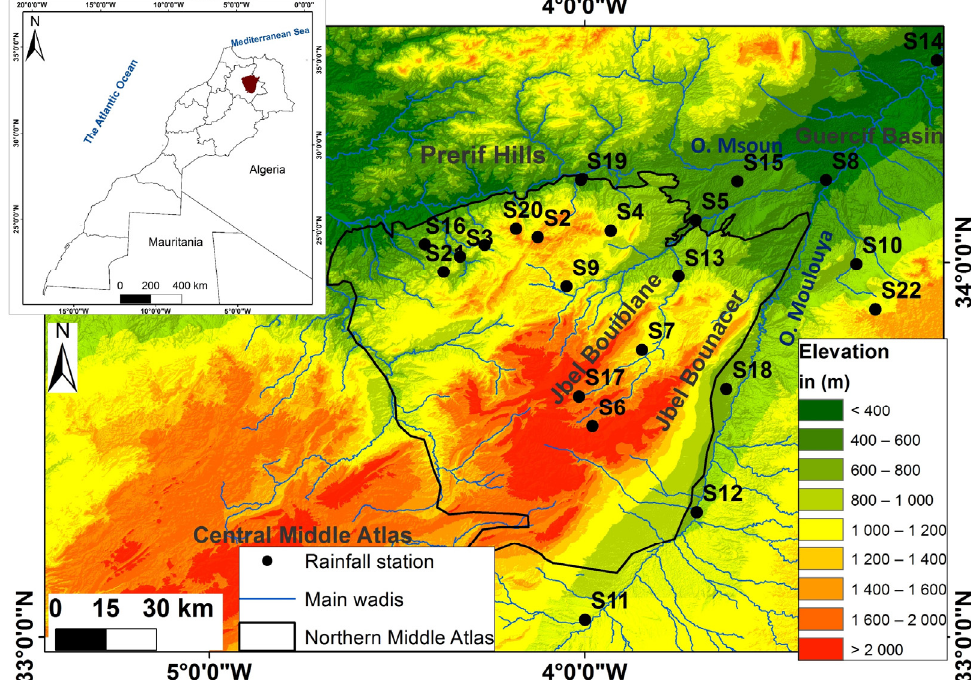
Figure 1. Geographical location of the northern Middle Atlas.